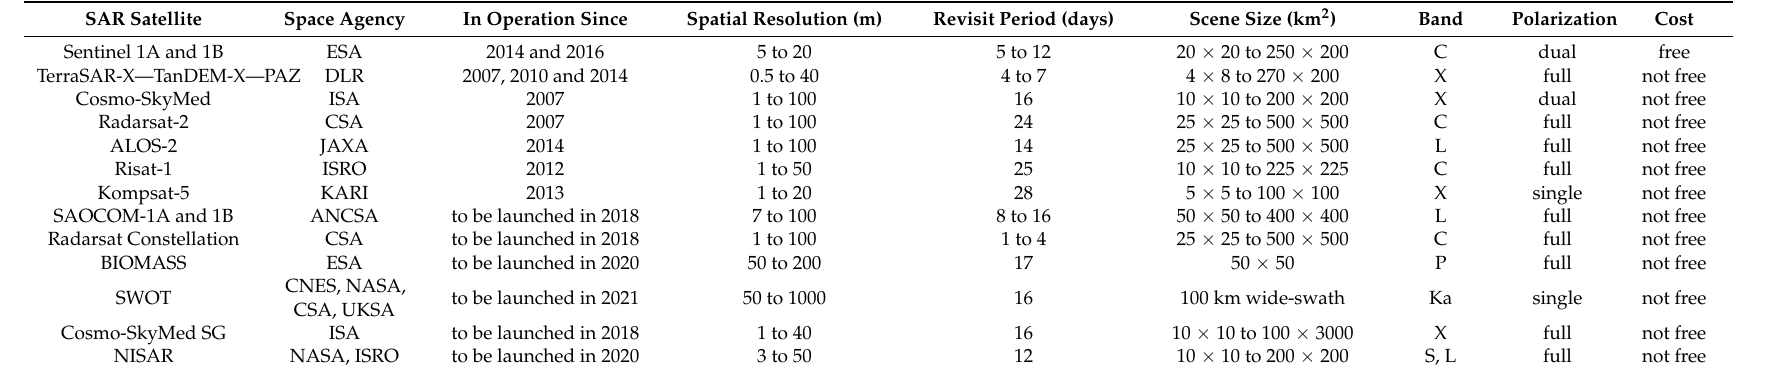
Table 2. SAR sensors currently in operation or to be launched in the next few years and their main characteristics. ESA = European Space Agency, DLR = German Aerospace Center, ISA = Italian Space Agency, CSA = Canadian Space Agency, JAXA = Japanese Space Agency, ISRO = Indian Space Research Organization, KARI = Korean Aerospace Research Institute, ANCSA = Argentina National Commission for Space Activities, CNES = French Space Agency, NASA = National American Space Agency, UKSA = United Kingdom Space